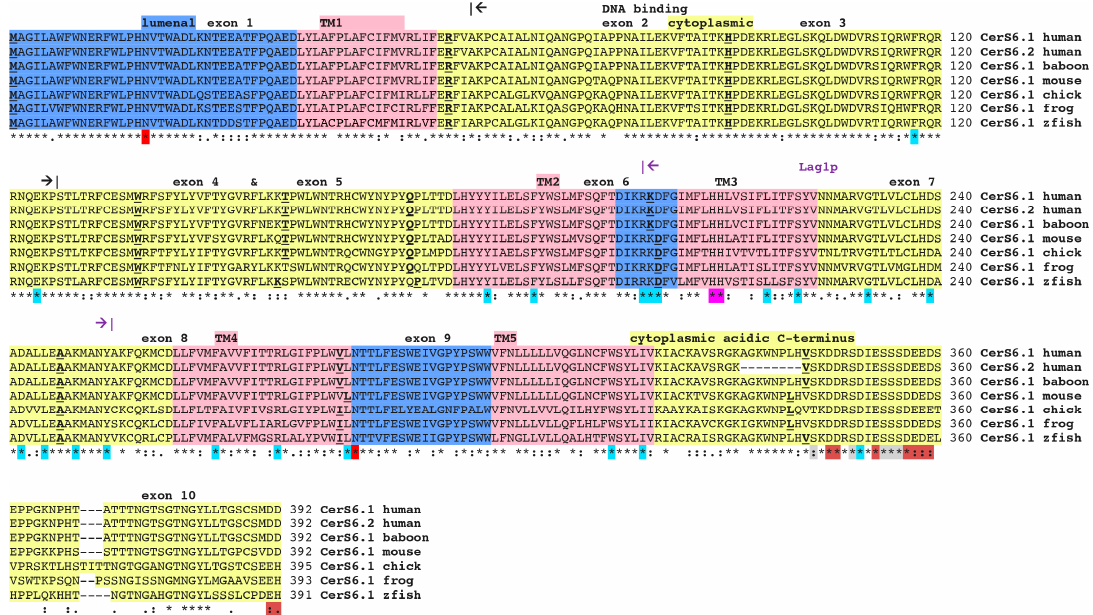
Figure 1. Amino acid sequence alignments for vertebrate CerS6 enzymes: See Table 1 for sources of sequences; * shows identical residues for polypeptides; - similar alternate residues; - dissimilar alternate residues; exon start sites are underlined and in bold; predicted lumenal sites are shown in blue; predicted transmembrane sequences are in pink and numbered TM1–5 from N-terminal end; predicted cytoplasmic regions are in yellow; a predicted homeobox DNA binding domain (residues 66–127) is shown by black arrows; the Lag 1p motif (residues 202–253) is denoted by violet arrows; two predicted N-glycosylation sites in lumenal regions are shown in red; the two adjacent histidine residues (His) in the active site are in magenta; the acidic C-terminal domain is indicated, with acidic amino acid residues marked in brown and C-terminal serine (Ser) residues subject to phosphorylation shown in grey; 21 conserved residues for all CerS1–6 and yeast LAC1 sequences are shown in cyan; zfish refers to the zebra fish sequence. Note differences in sequences between human CERS6.1 and CERS6.2 isoforms. Sequence alignment has been completed using CLUSTAL Omega (EMBL-EBI, Hinxton, Cambridgeshire, UK, https://www.ebi.ac.uk/Tools/msa/clustalo/).